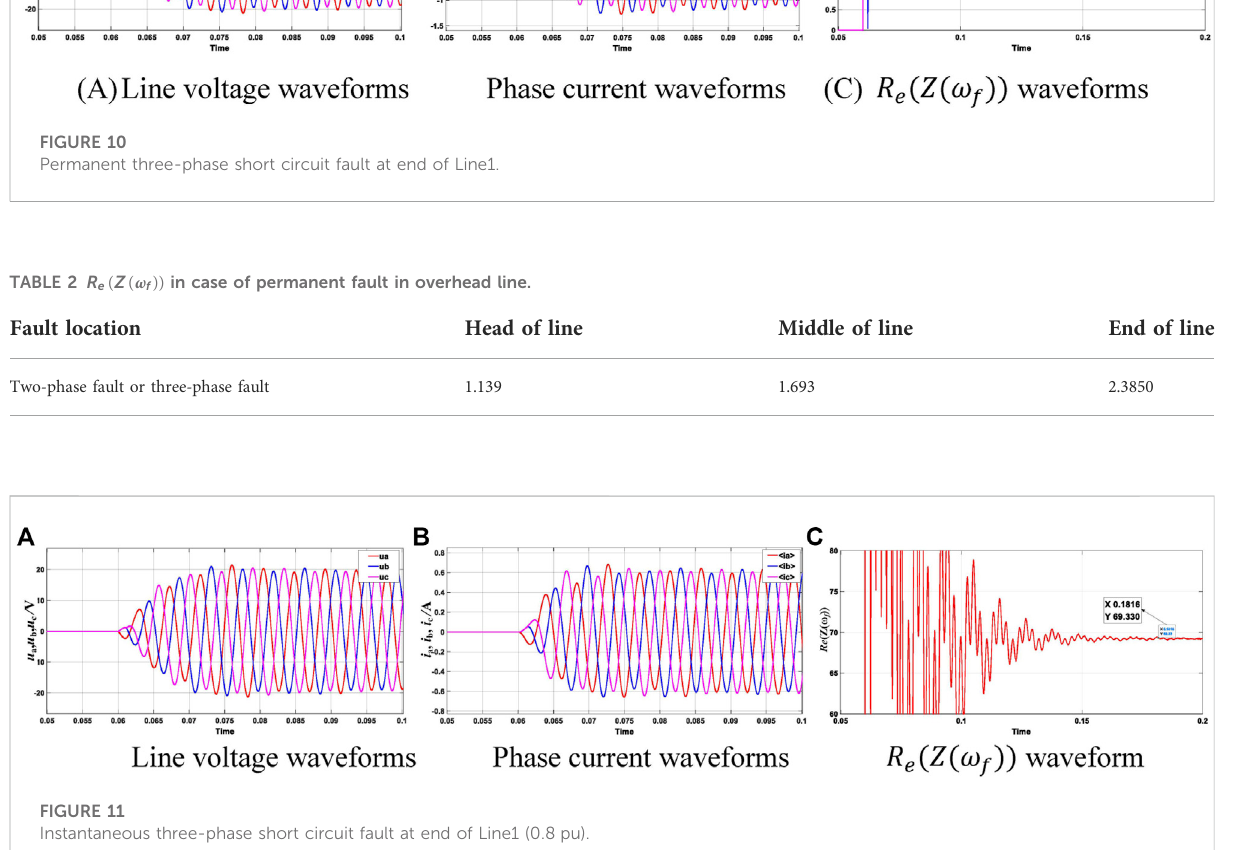
FIGURE 11 Instantaneous three-phase short circuit fault at end of Line1 (0.8 pu).